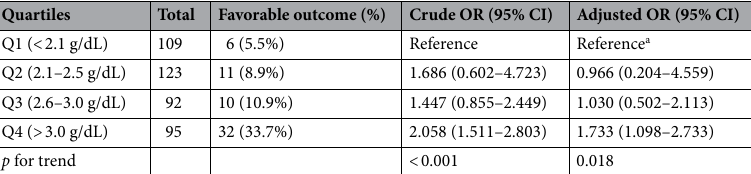
Table 3. Discharge with favorable neurologic outcome by albumin quartiles in the derivation cohort. OR odds ratio, CI confidence interval, GO-FAR score Good Outcome Following Attempted Resuscitation score. a Adjusted for liver cirrhosis, active cancer, diagnosis at admission, shockable rhythm, resuscitation duration, presumed cardiac cause, GO-FAR score.